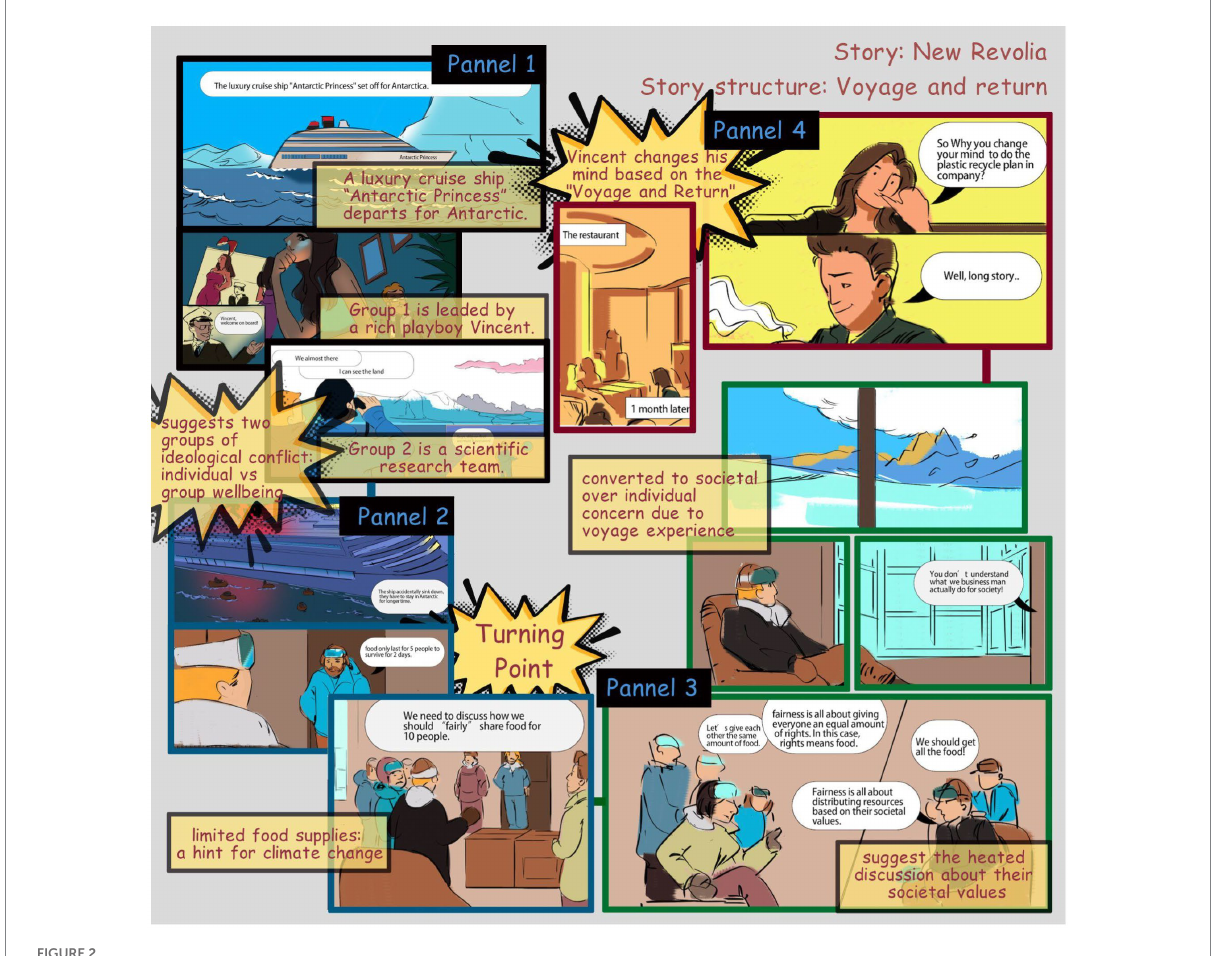
FIGURE 2 Contextual storytelling by visual design in New Revolia